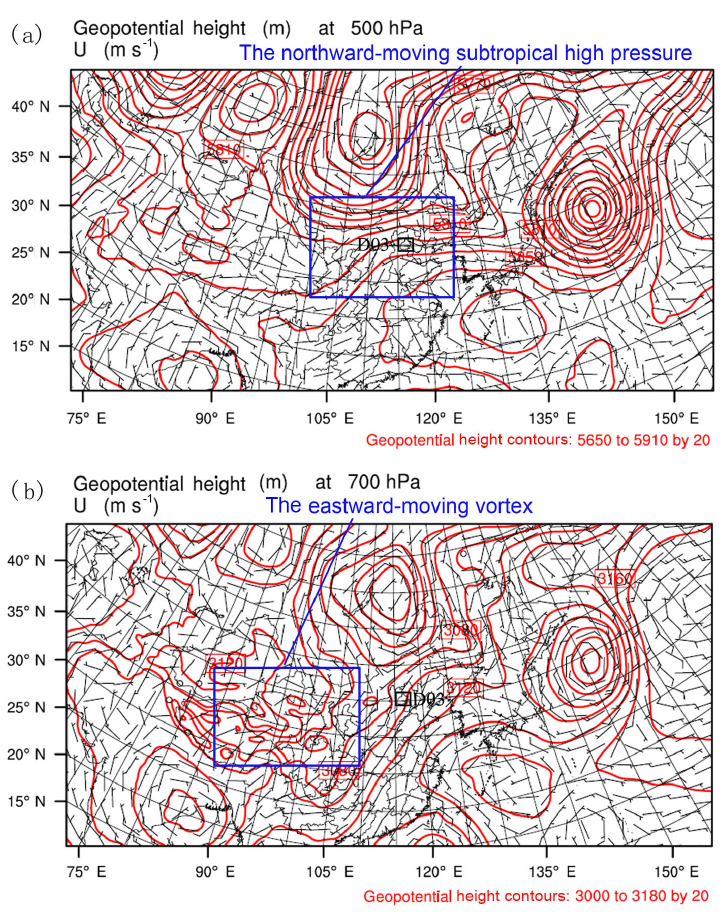
Figure 2. Initial wind field and geopotential height field at 00:00UTC on 20 July 2012 over the Northern Hemisphere obtained from the ERA-Interim reanalysis. (a) The fields at 500hPa; (b) the fields at